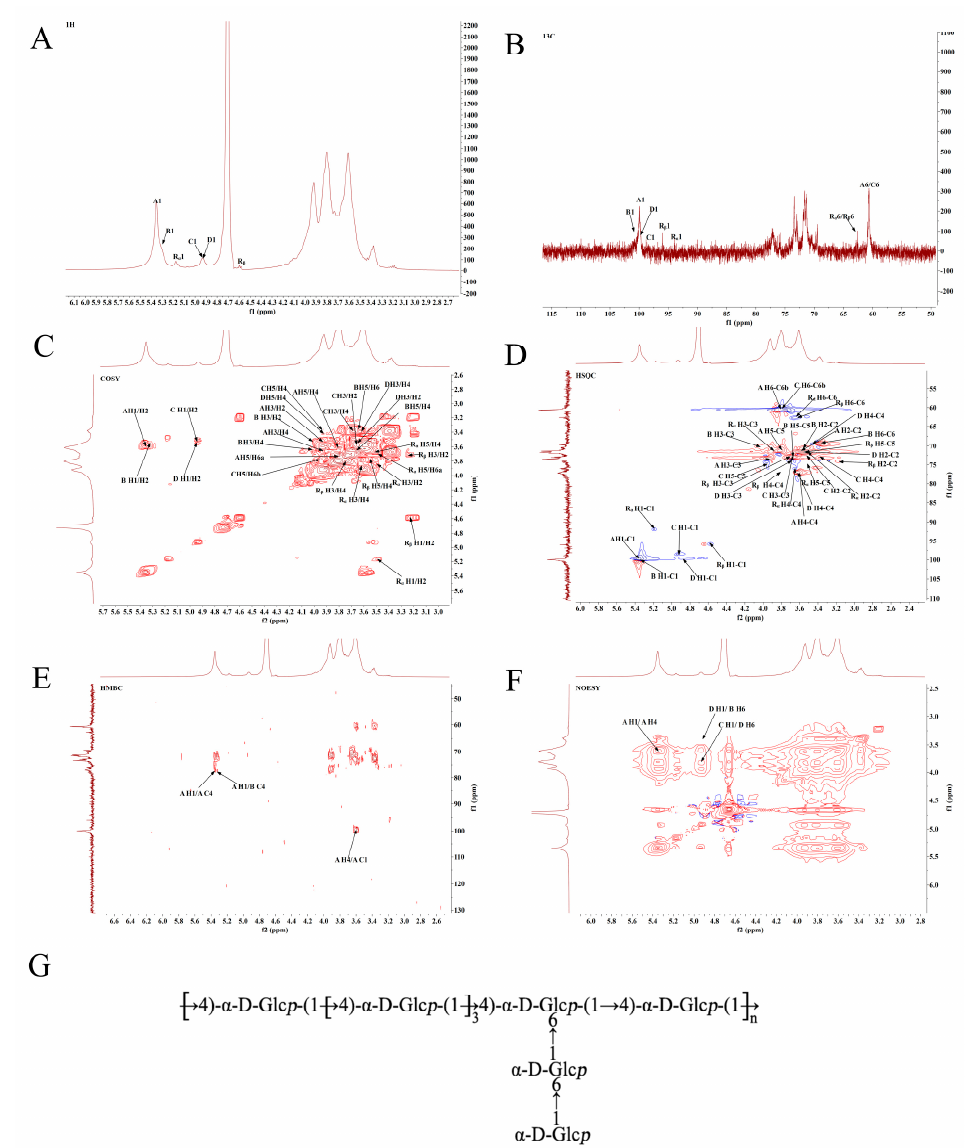
Figure 3. NMR spectra and proposed structures of MSP1-1. ( A ) 1 H NMR, ( B ) 13 C NMR, ( C ) 1 H/ 1 H correlation spectroscopy (COSY), ( D ) heteronuclear single quantum correlated spectroscopy (HSQC), ( E ) heteronuclear multiple bond correlation (HMBC), and ( F ) nuclear overhauser effect spectroscopy (NOESY); ( G ) proposed structures of MSP1-1.